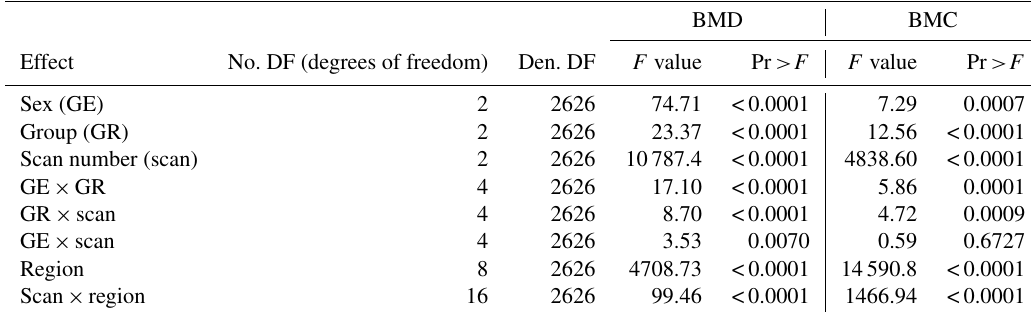
Table 4. Variance analysis table for bone mineral traits (BMD/BMC).